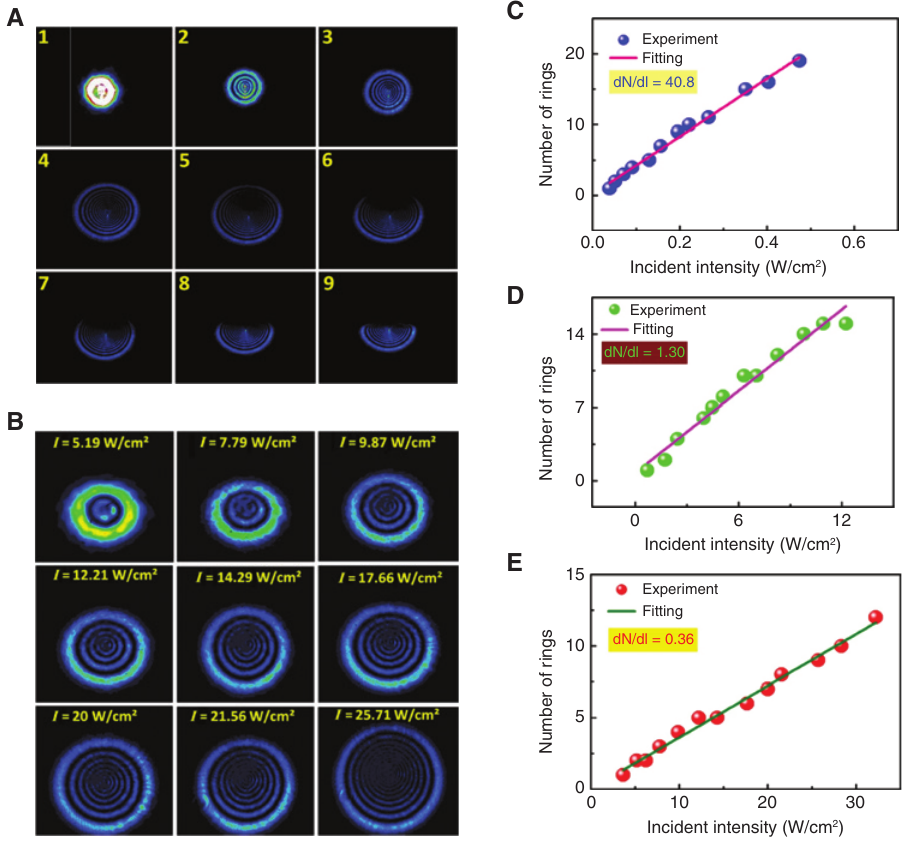
Figure 4: The experimental and data of SSPM. (A) Whole process of diffraction ring, (B) the image of diffraction ring in variety incident intensity, (C), (D), and (E) are the number of the diffraction rings corresponding to the different incident intensity at λ = 457 nm, λ = 532 nm, and λ = 671 nm,